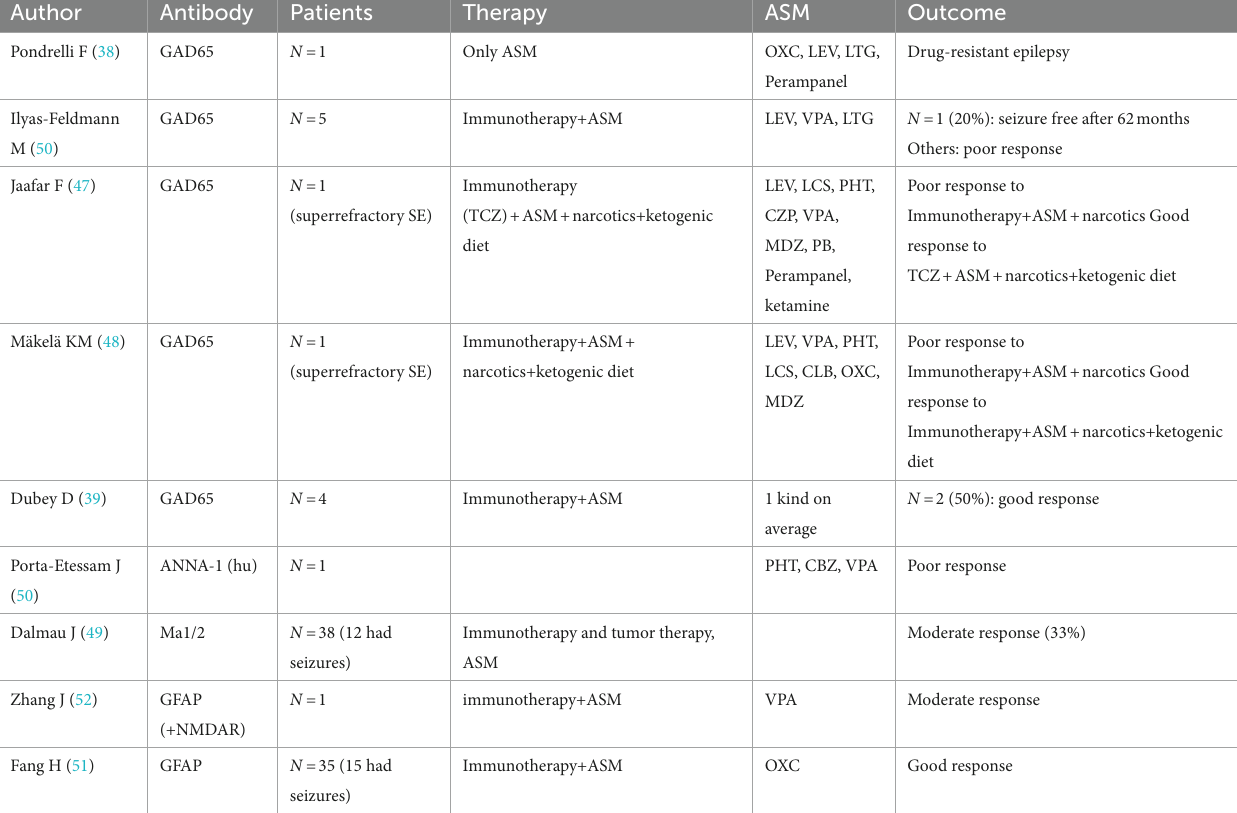
TABLE 8 Use of ASMs in anti-GAD65 AE and other intracellular antibody-mediated